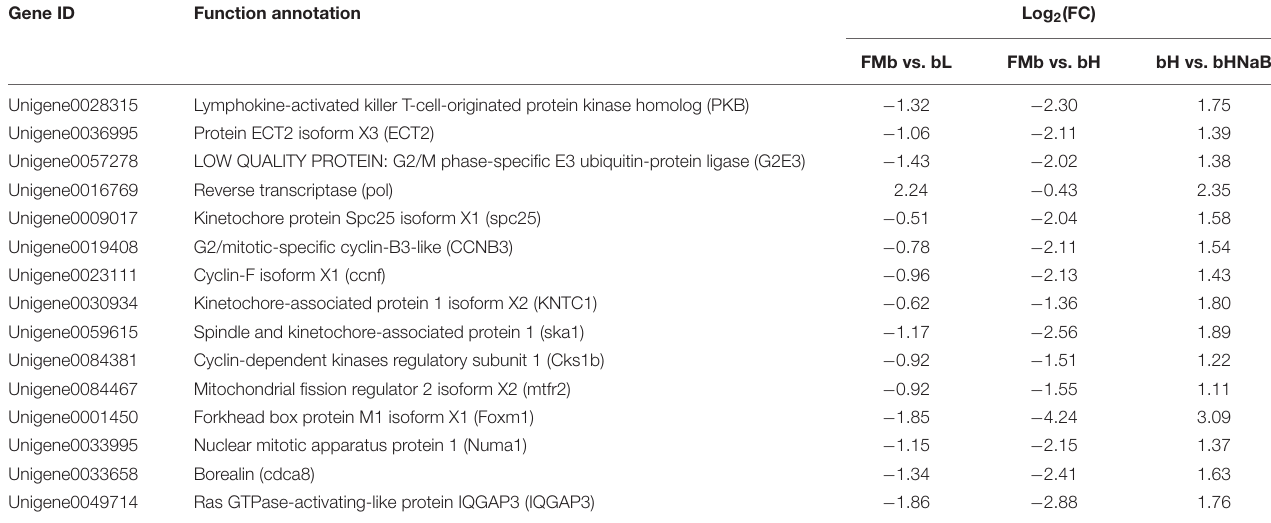
TABLE 1 | Significantly changed DEGs in distal intestine of hybrid